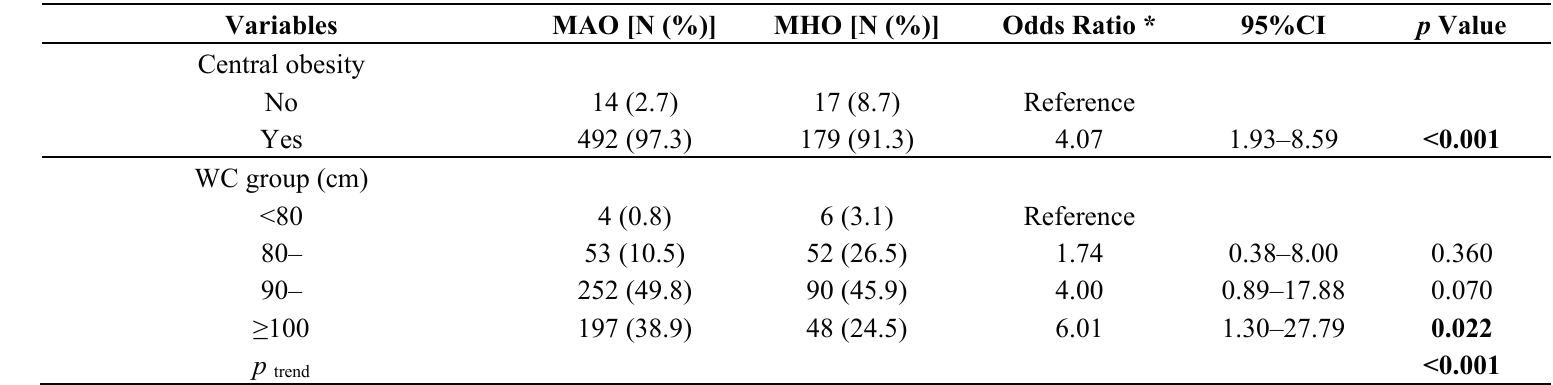
Table 3. Multiple-adjusted odds ratios for metabolically abnormal phenotype associated with demographic and lifestyle factors in obese